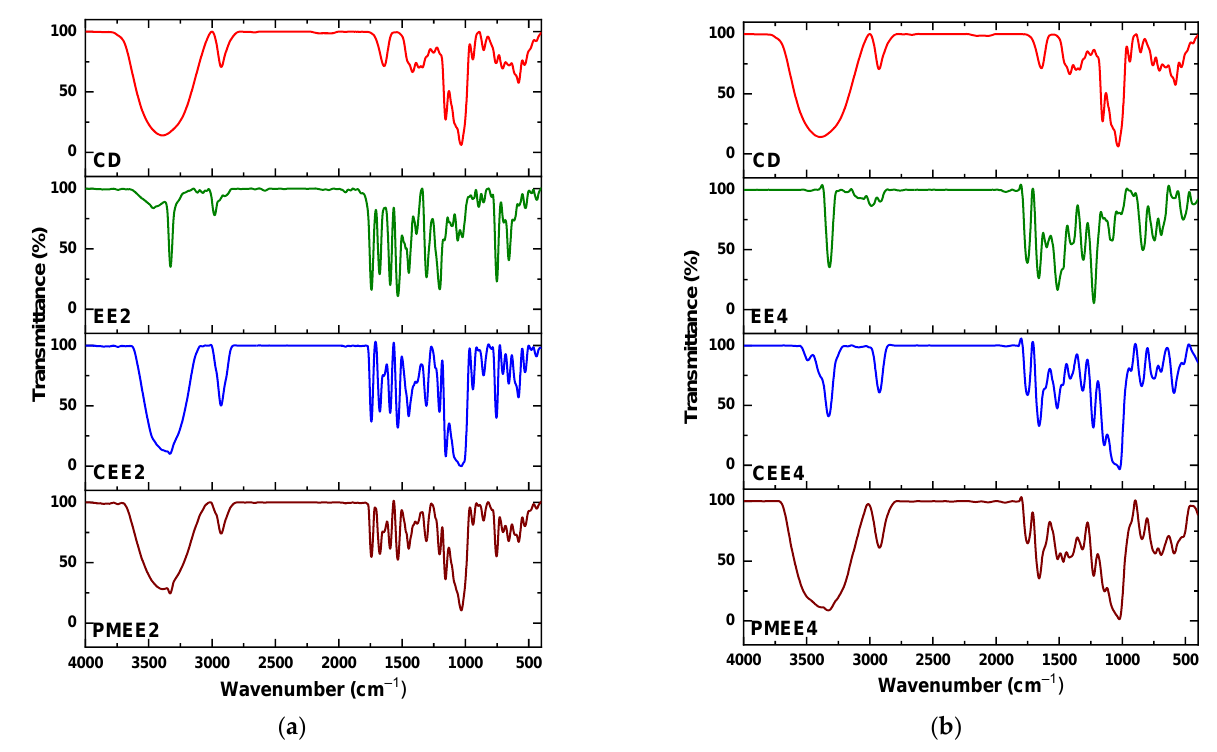
Figure 3. FTIR spectra of β -cyclodextrin, ethyl ester, inclusion complex, physical mixture: ( a ) ethyl 2(2-((2-chlorophenyl)carbamoyl)phenoxy)acetate series; ( b ) ethyl 2-(2-((4-chlorophenyl) car- bamoyl)phenoxy)acetate series.